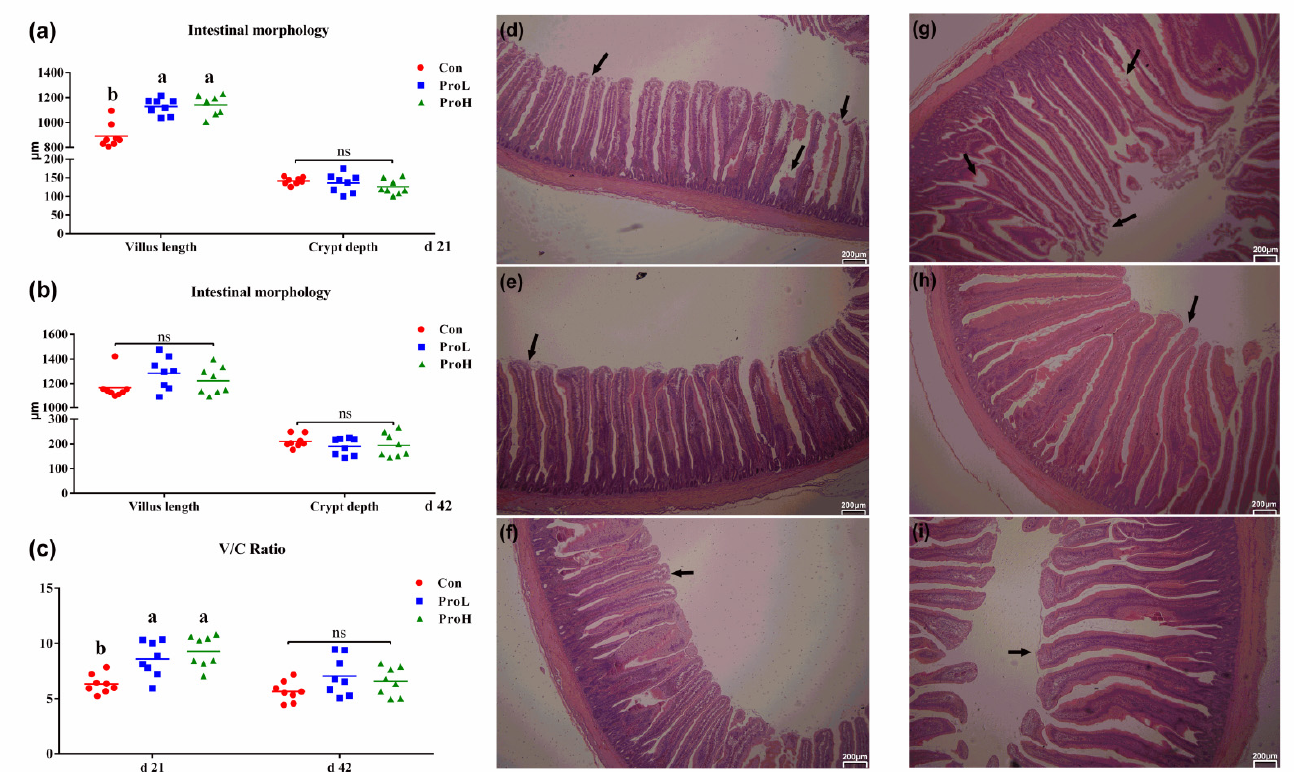
Figure 2. Effects of compound probiotic supplementation on the ileal morphology in broilers. ( a ) ileal villus length and crypt depth on d 21; ( b ) leal villus length and crypt depth on d 42; ( c ) V/C ratio; ( d ) ileal microvillus morphology of Con birds on d 21; ( e ) ileal microvillus morphology of ProL birds on d 21; ( f ) ileal microvillus morphology of ProH birds on d 21; ( g ) ileal microvillus morphology of Con birds on d 42; ( h ) ileal microvillus morphology of ProL birds on d 42; ( i ) ileal microvillus morphology of ProH birds on d 2. a, b, and c in the same figure represent significant difference ( p < 0.05); ns represents no significant difference. Con birds were fed a basal diet; ProL birds were fed a basal diet added into 10 10 probiotics cfu/kg; ProH birds were fed a basal diet added into 10 11 probiotics cfu/kg ( n = 8). Scale bar 200 µm.